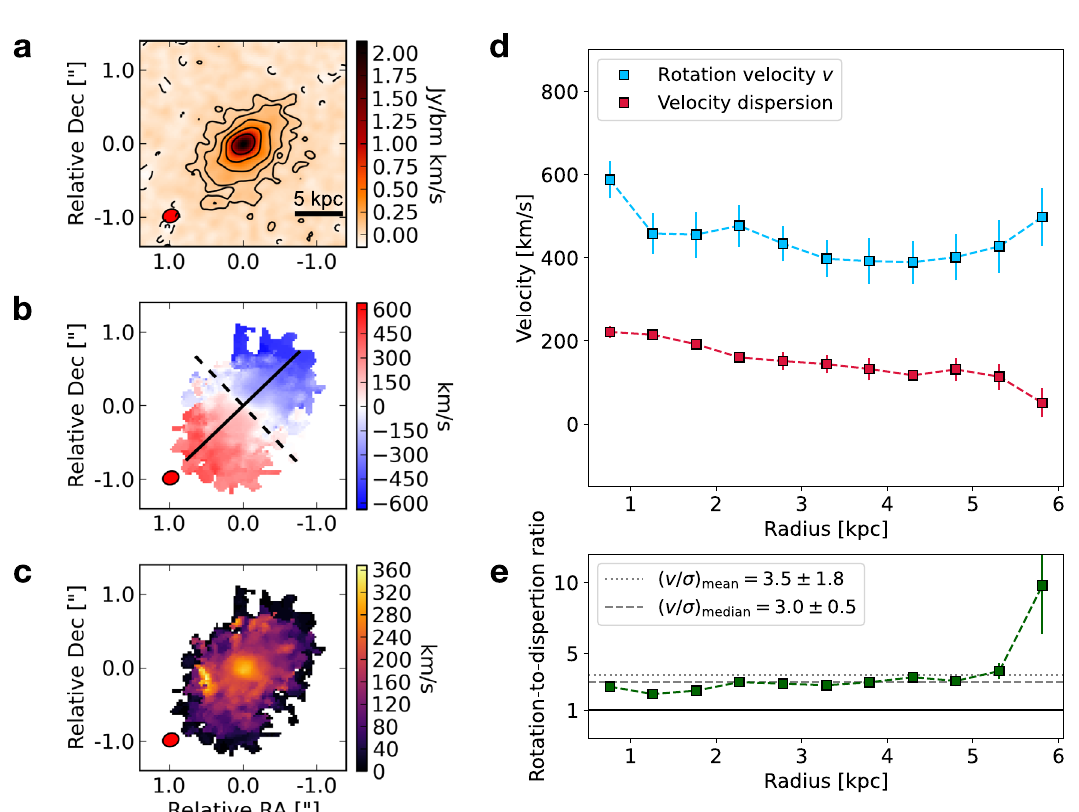
Fig.4|ALMACO(6-5)observationsofW0410-0913showthatitsmolecularISM is structured in a rotationally-supported fast-rotating disk. In panel a we show the moment-0 (velocity-integrated intensity), in panel b the moment-1 (velocity fi eld),andinpanel c themoment2(velocitydispersion fi eld).Theblacksolidlinein thelower-leftcornerofthemoment-0panelshowsa5kpcphysicalscale.Thesolid line in the moment-1 represents the kinematic major axis, while the dashed line representstheminoraxis.Theblackcontoursinthemoment-0representthe±[2,4, 8,16, 32] σ levels emission, where σ =3.3×10 − 2 Jybeam − 1 kms − 1 is the root mean